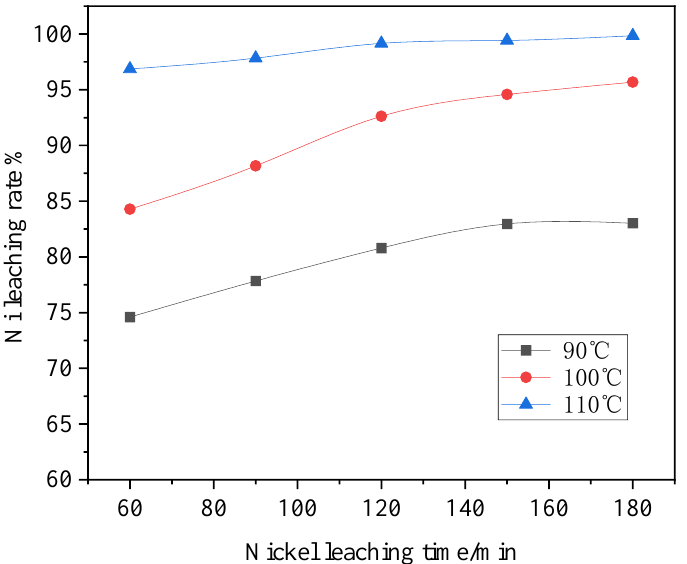
Figure 6. Effect of leaching time on Ni leaching rate at different temperatures.